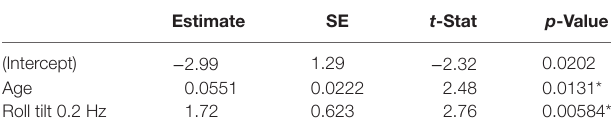
TaBle 7 | Results of a multiple logistic regression after application of a stepwise algorithm to provide a simplified model. estimate se t -stat p